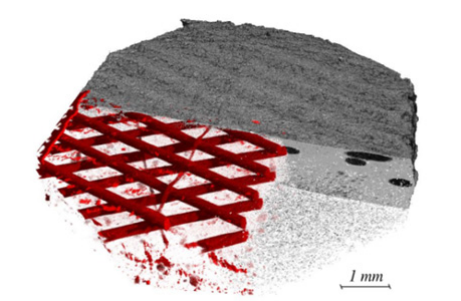
Fig. 3 Micro-CT image of a cut-out section of bias-ply tyre as used in the pendulum impact test: angled nylon plies in rubber matrix.